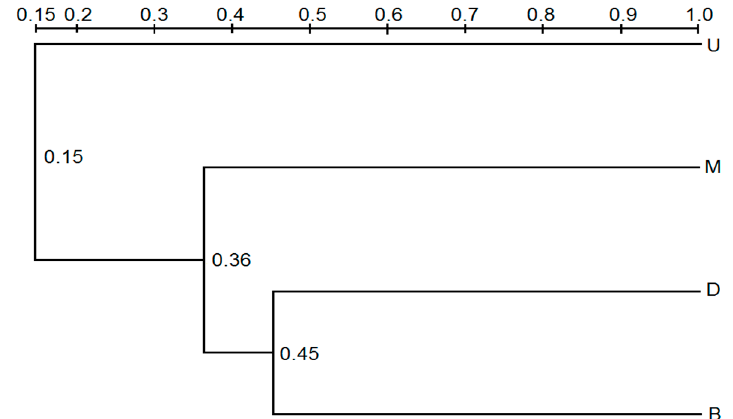
Figure 3. Clustering analysis of fungal DGGE profiles. The similarity was calculated using Euclidean distance and clustering was performed using UPGMA. U, M, D, and B represent samples from the up wall layer of cellar, middle wall layer of cellar, down wall layer of cellar, and bottom layer of cellar.